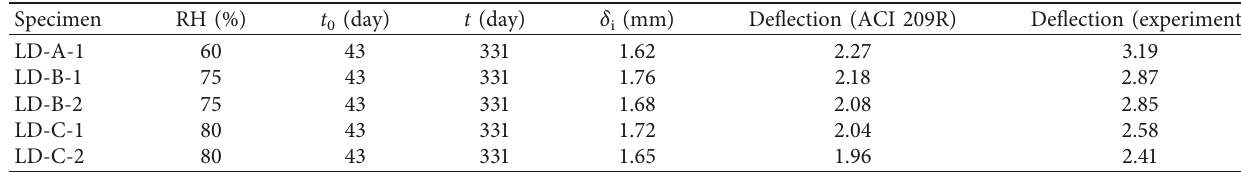
Figure 12: Long-term deflections compared with the analytical model: (a) Beam LD-A-1; (b) Beams LD-B-1 and LD-B-2; (c) Beams LD-C-1 and LD-C-2. Table 6: Parameters and the predicted deflections at 331 days after